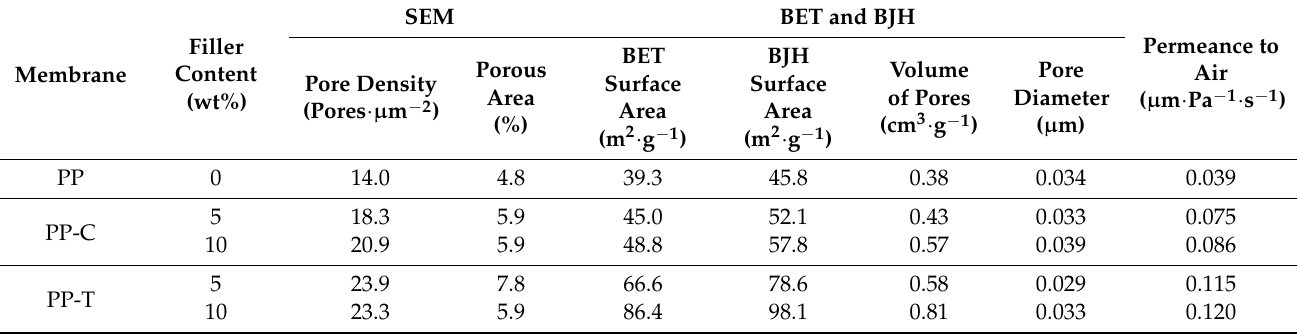
Figure 5. Pore volume distribution in trilayer membranes with outer layers consisting of: ( a ) neat polypropylene (PP), ( b ) polypropylene filled with calcium carbonate (PP-C) and ( c ) polypropylene filled with talc (PP-T). Filler content: < (cid:78) 5 wt%>, < (cid:4) 10 wt%>; ( d ) correlation between the permeance to air and Brunauer-Emmett-Teller (BET) surface area of the 5 membranes analysed. Table 2. Parameters obtained from scanning electron microscope (SEM) and Brunauer–Emmett–Teller (BET)–Barrett, Joyner and Halenda (BJH) analyses, and Gurley tests carried out on trilayer membranes. Membrane code refers to the outer PP-based